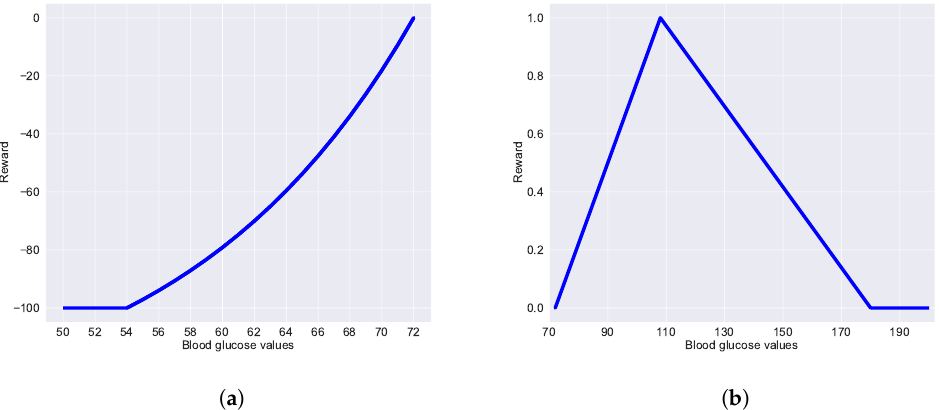
Figure 3. The asymmetric reward function. Low blood glucose levels ( a ) are more penalized than ( b ) high blood glucose